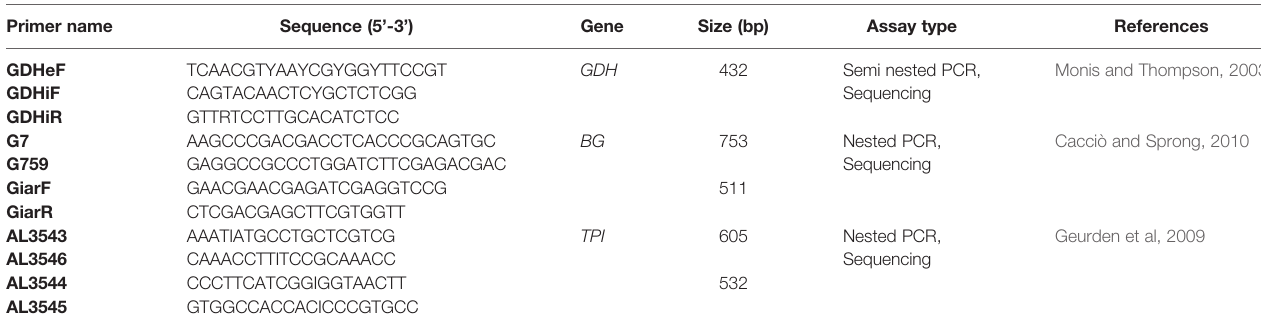
TABLE 1 | Primers, targets, sizes and assay type used for G. duodenalis